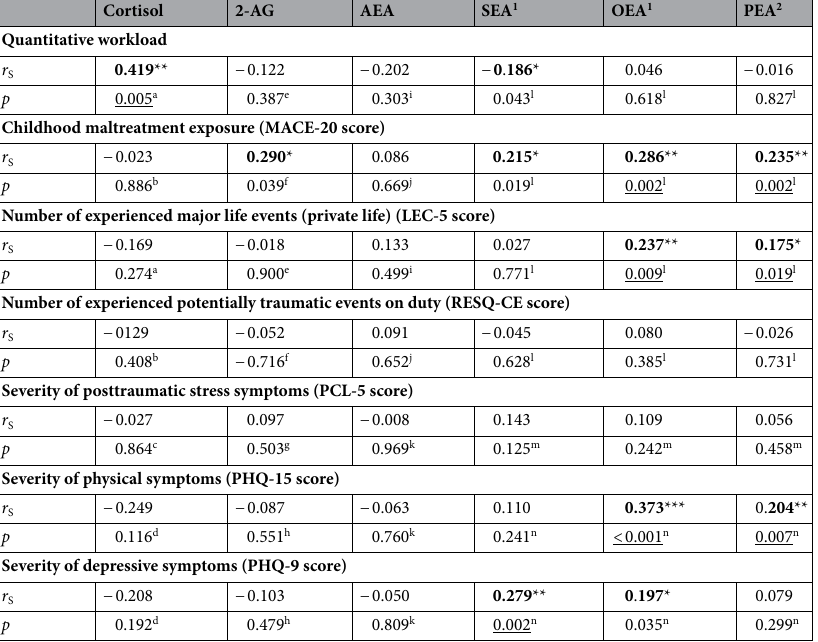
OEA and PEA hair concentrations. There were no significant associations of endocannabinoid or NAE hair concentrations with exposure to potentially traumatic mission aspects. Hair concentrations of endocannabinoids and NAEs did not consistently correlate with the participants’ subclinical posttraumatic, depressive, and physical stress symptoms. Higher OEA and PEA concentrations were associated with more severe subclinical physical symptoms; higher SEA and OEA concentrations were linked to more severe subclinical depressive symptoms.